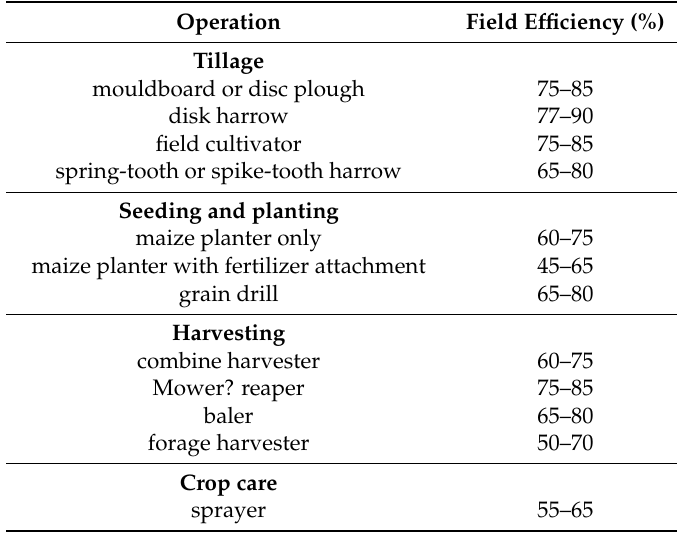
Table 1. Typical field efficiencies for various tractor-powered